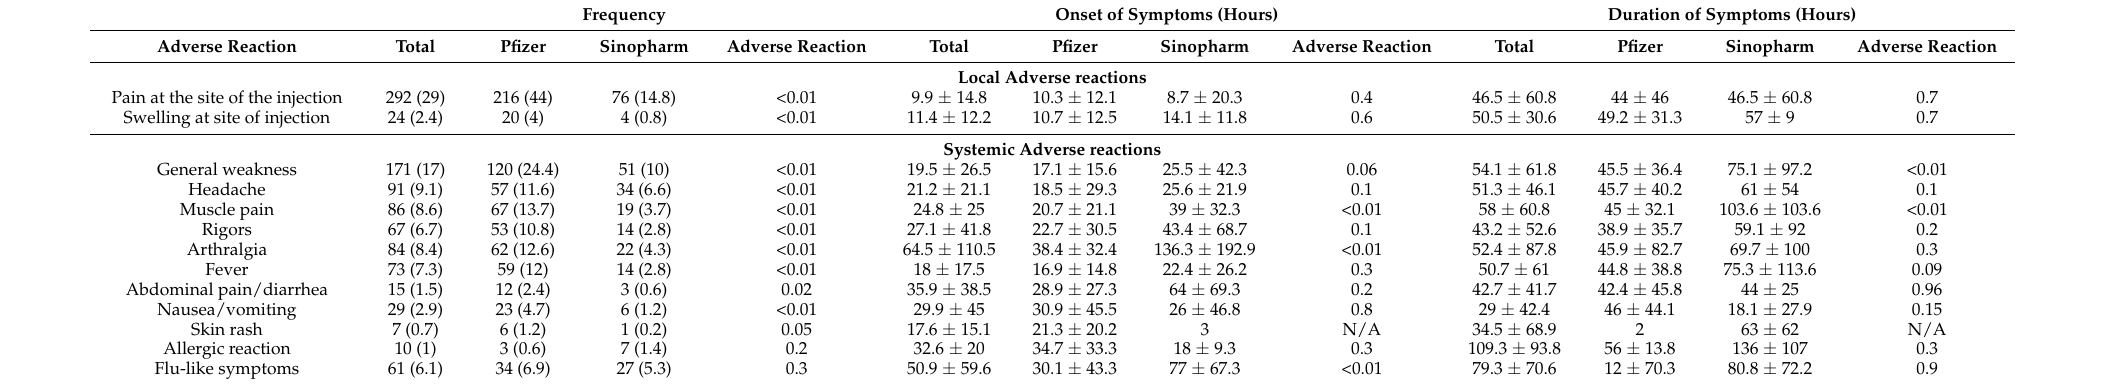
Table 4. The frequencies, onset, and duration of the specific adverse reactions after the second dose of the